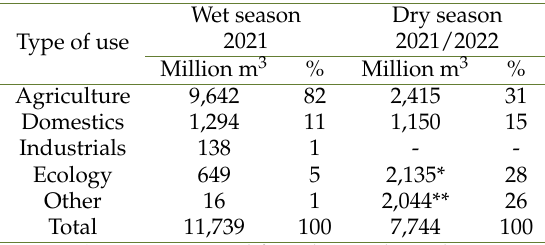
Table 2. Water resource management plans for